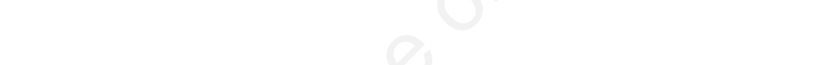
Figure 1. Levels of triglycerides in snails µmol/g (mean value and standard deviation).